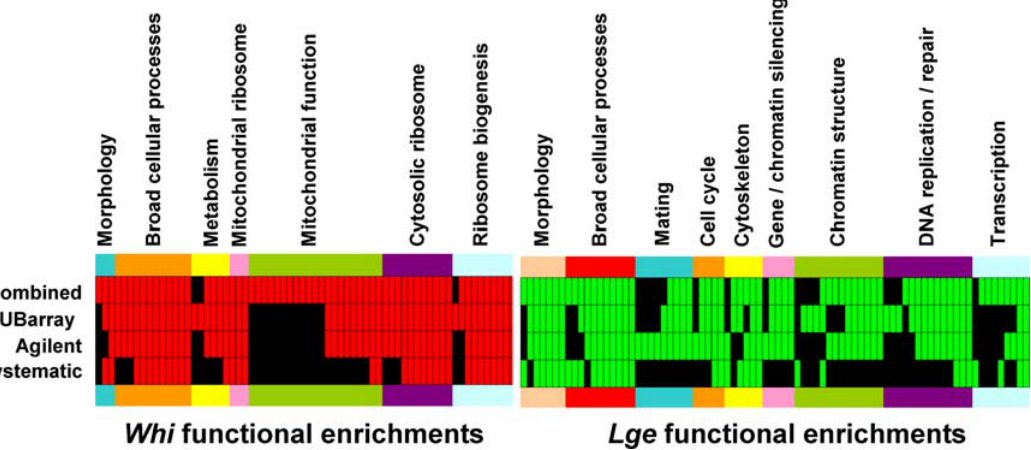
Figure 4. Barcode elutriation and systematic cell size enrichment of gene ontology (GO) annotations. Statistical enrichment from the haploid deletion set was calculated using cumulative hypergeometric probability functions (CDFs) with Bonferroni correction for either the high confidence systematic cell size data; SUBarray or Agilent array data; or the combined set of all whi or lge deletion strains identified. Significant enrichment for whi (red bars) or lge (green bars) strains is defined by [p*N , 0.01, where N is the number of categories per subset)]. GO component (N=330); GO process (N=1380); Morphology (N=11) [27]. GO categories are arranged by related function.